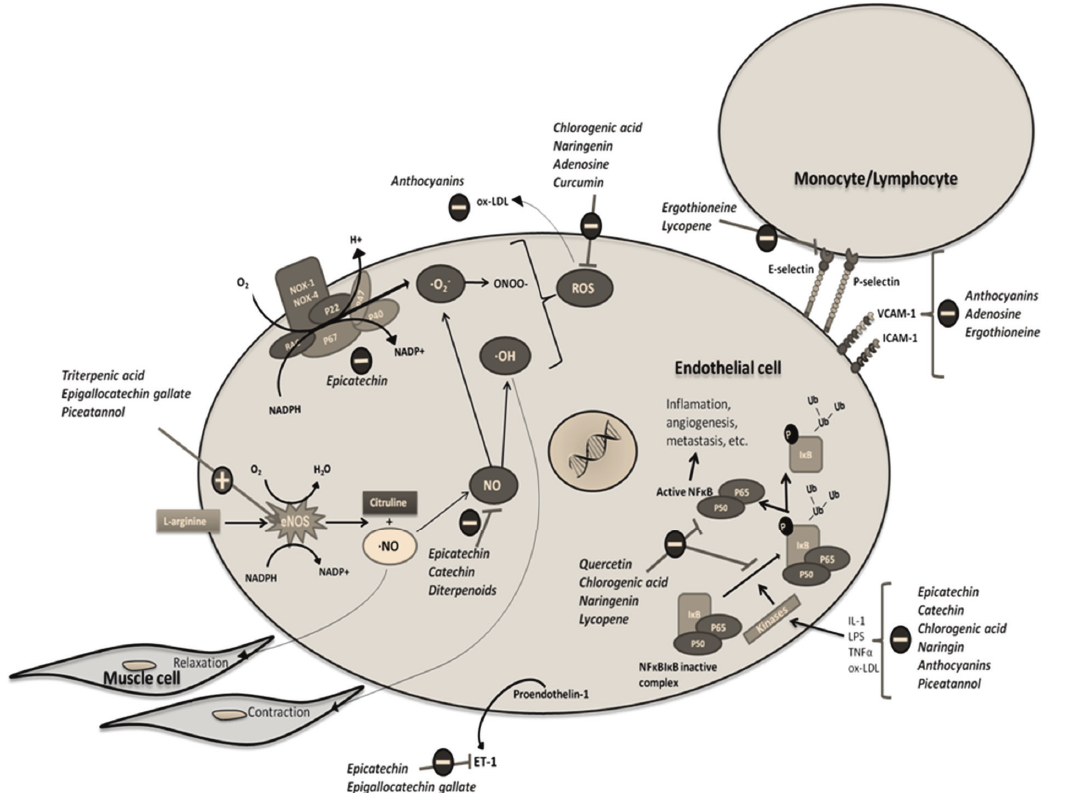
Figure 1 - The main mechanisms of endothelial protection by natural bioactive compounds. Anthocyanins, Adenosine and Ergothioneine inhibit adhesion molecules VCAM-1, ICAM-1, E-selectin, P-selectin. Lycopene and Ergothioneine inhibit leukocyte adhesion to endothelium. Epicatechin, Catechin, Chlorogenic acid, Naringin, Anthocyanins and Piceatannol inhibit proinfl ammatory molecules. Quercetin, Chlorogenic acid, Naringenin and Lycopene inhibit NFkB signaling pathways and preventing infl ammation, angiogenesis, metastases, etc. Epicatechin, Catechin and Diterpenoids lower levels of nitric (NO) bioavailability and inhibit rust. Chlorogenic acid, Naringenin, Adenosine and Curcumin decrease reactive oxygen species (ROS). Anthocyanins decreases levels of oxidized LDL (ox-LDL). Epicatechin inhibit NADPH oxidase. Triterpenic acid, Epigallocatechin gallate and Piceatannol activate endothelial nitric oxide synthase (eNOS). Epicatechin and Epigallocatechin gallate reduce endothelin-1